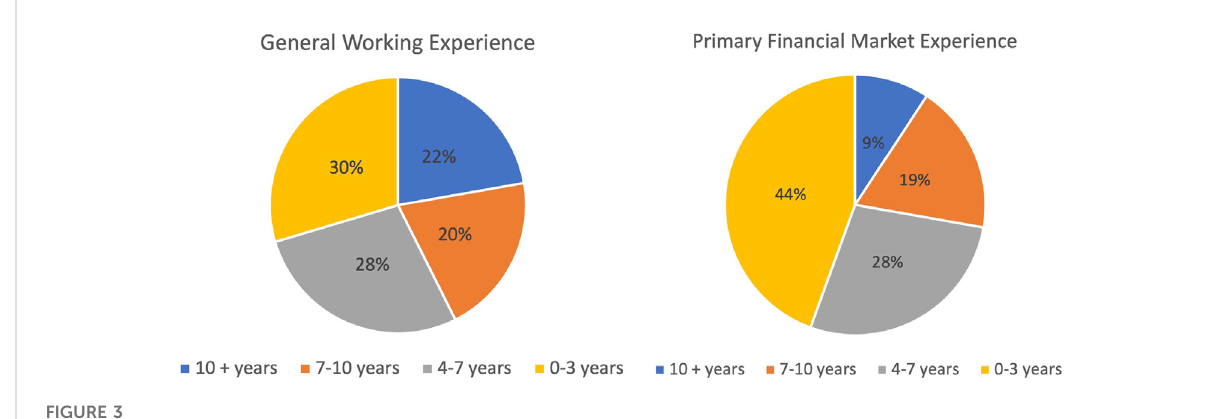
FIGURE 3 Pie charts of general working experience and primary fi nancial market experience in